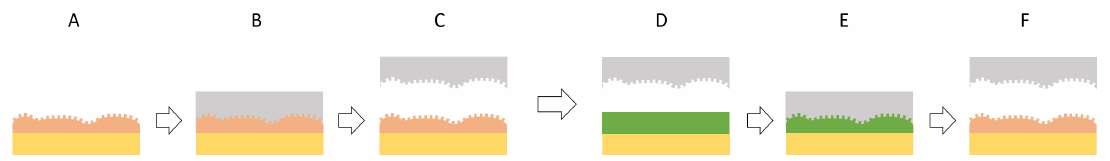
Figure 4. Process flow for stamp fabrication ( A , B , C ) and single step nanoimprinting of hierarchical structures ( D , E , F ).